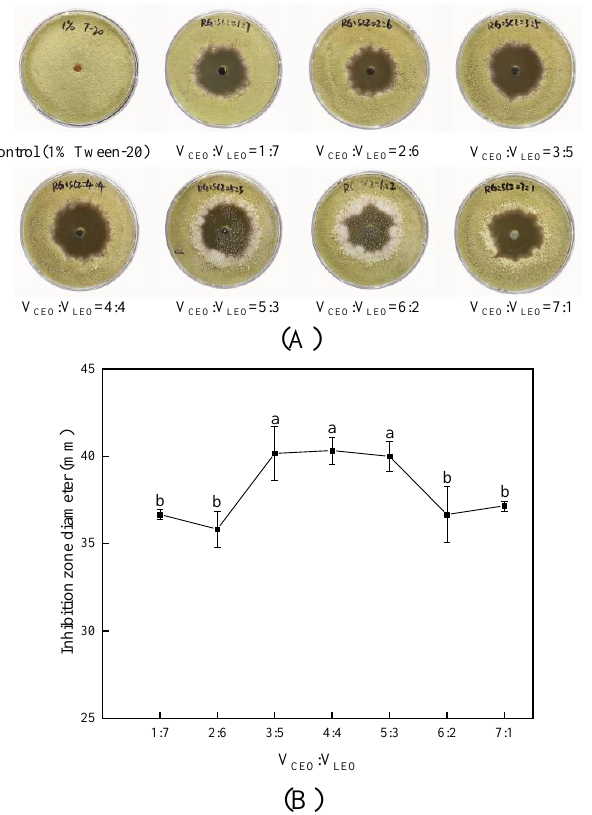
Figure 5. Antifungal effect of different combinations of CLCEO on strain YQM: ( A ) growth of strain YQM on 9-cm plate media; ( B ) quantification of inhibition as zone diameter. Values are average values ± standard deviation (biological replicates, n = 3). Values with different superscript lowercase letters show significant differences among treatments ( p < 0.05). Table 2. Chemical compounds of individual and combined essential oils.